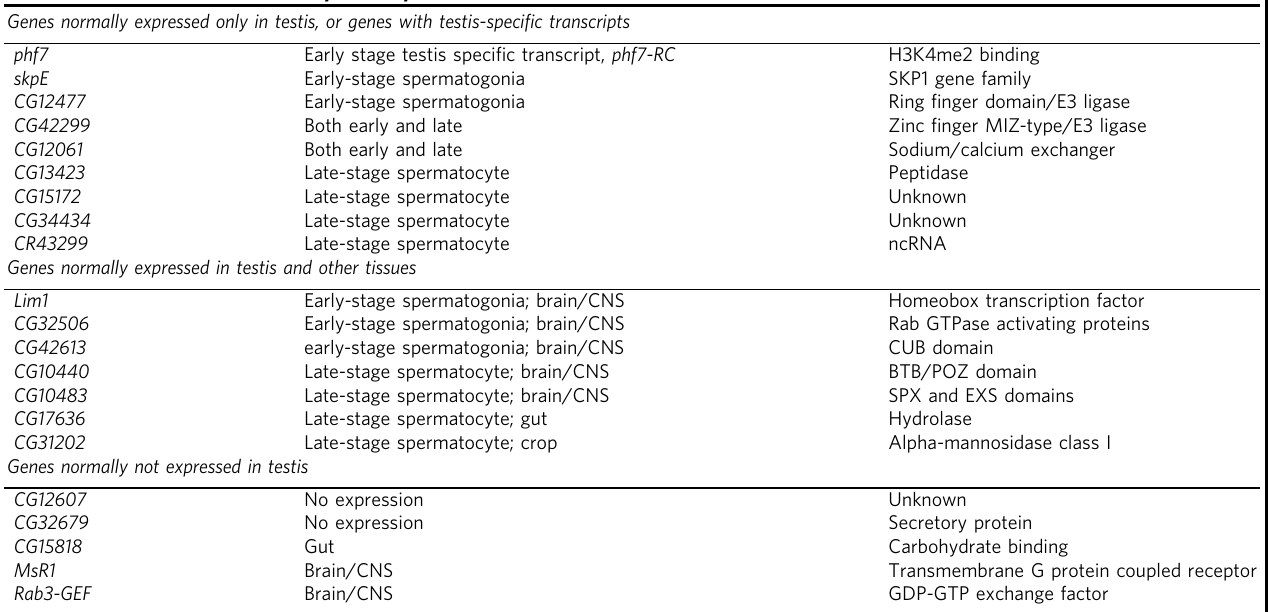
Table 1 SETDB1/H3K9me3 regulated genes in ovaries Gene Expression pattern in adults (see text) Predicted function Genes normally expressed only in testis, or genes with testis-speci fi c transcripts